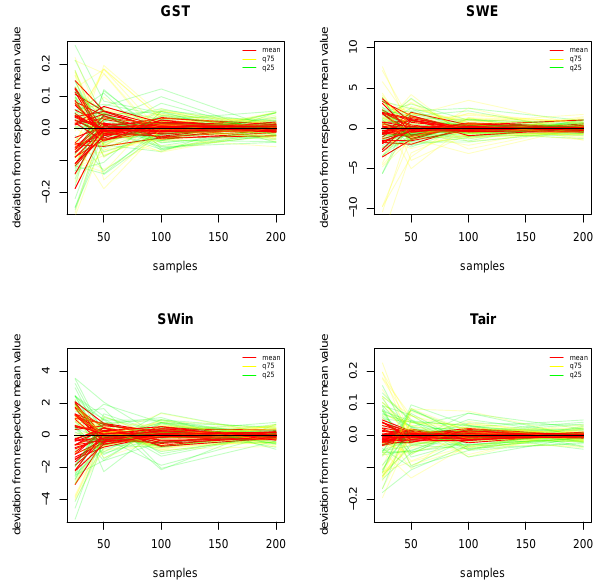
Fig. 13. Repeatibility of TopoSUB clustering success expressed as deviation from mean values of mean and quantiles 25 / 75 for 40 runs. Results at resolutions of 25–200 samples indicate reasonable stability even at low resolutions. A significant increase in stability is seen between 25–100 samples in all variables tested.